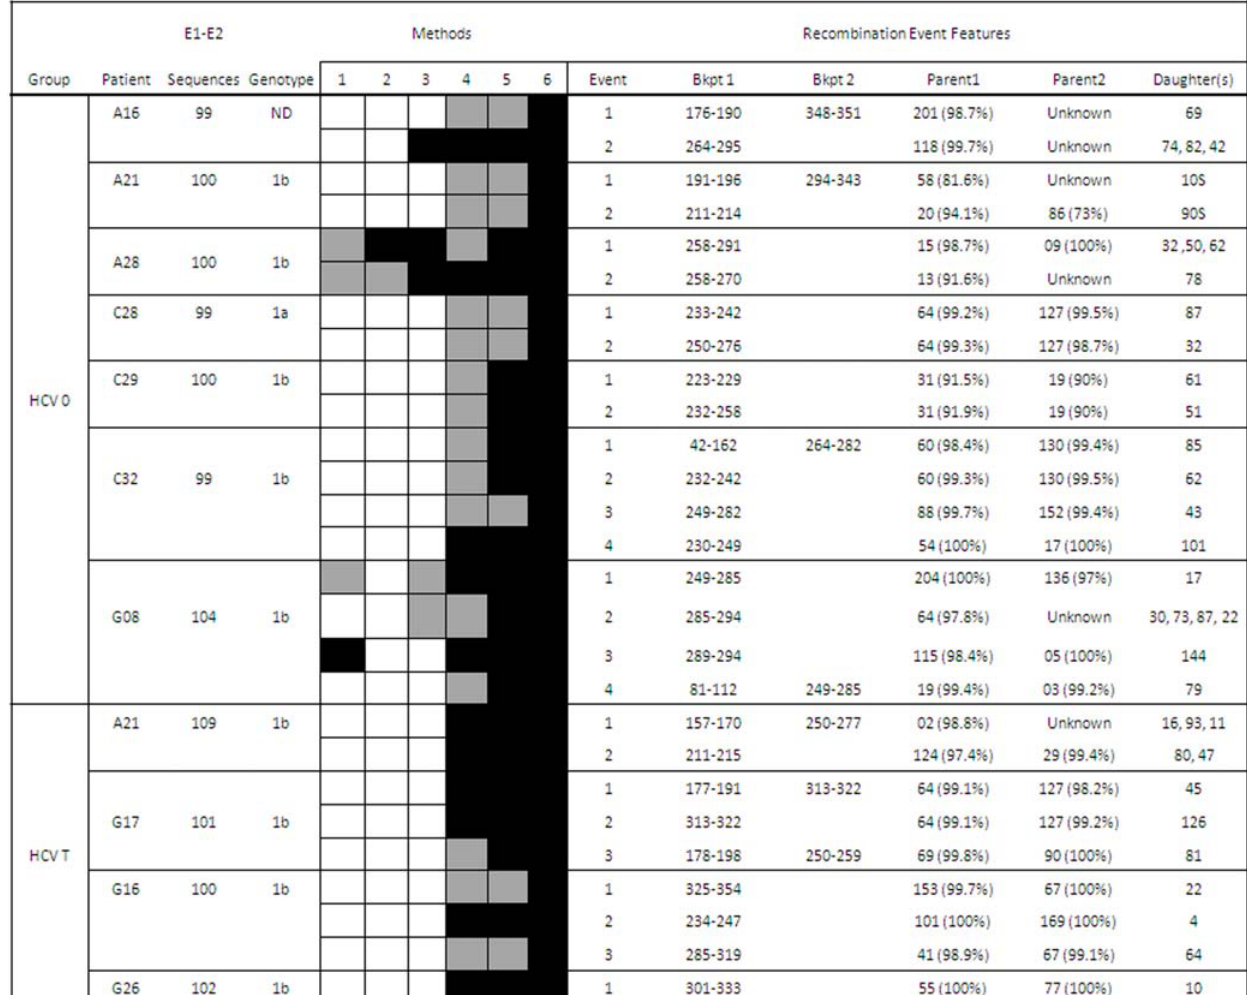
Figure 1. Summary of positive recombination results in the E1-E2 region (HCV-monoinfected patients). The columns represent: i) patient group before (HCV 0) or after (HCV T) antiviral treatment; ii) patient code; iii) amplified sequences for this patient and region; iv) HCV genotype; v) p-values for the different recombination detection methods implemented in RDP 3.0 (1=RDP, 2=Geneconv, 3=Bootscan, 4=Maxchi, 5=Chimera, and 6=Siscan) using the following color coding: non-significant p-values (white filling), p , 0.05 (grey) and p , 0.01 (black); vi) recombination event number; vii) Bkpt 1, location range for breakpoint 1; viii) Bkpt 2, location range for breakpoint 2; ix) parent1 sequence (% similarity to daughter sequence); x) parent2 sequences(% similarity to daughter sequence); and xi) daughter sequence(s). Only events detected as significant by at least three methods are shown.